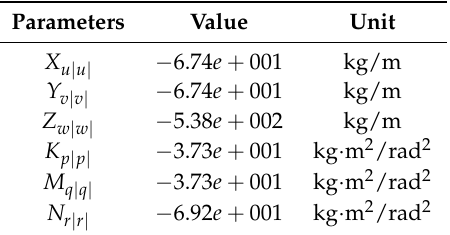
Table 2. Hydrodynamic Damping Coefficients.